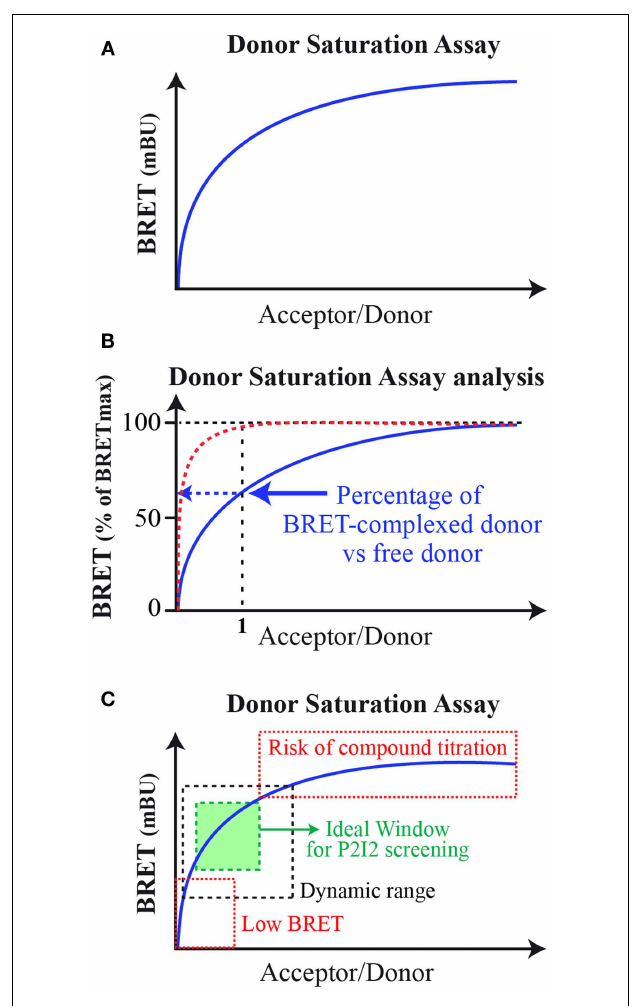
FIGURE 2 | Bioluminescence resonance energy transfer donor saturation assay. (A) Basic donor saturation assay expressed as milliBRET unit (mBU); (B) Donor Saturation Analysis for dimeric complexes formation: in red, theoretical curve if 100% donor and acceptor interact with each other at a 1/1 molar ratio. In blue, the common DSA curves obtained showing lower percentage of donor/acceptor complexes in cells. (C)